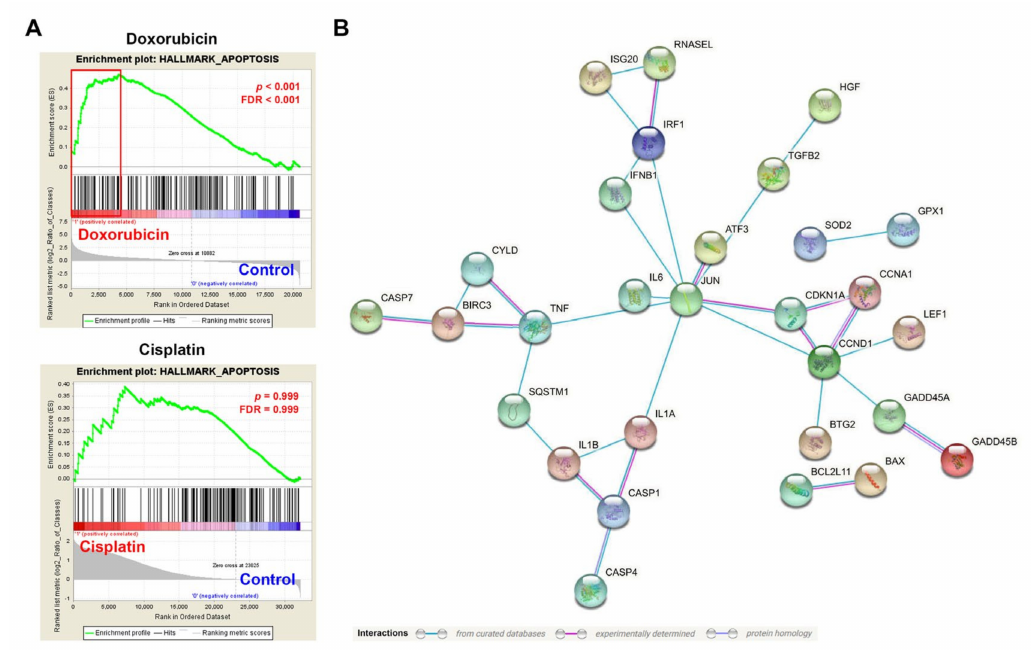
Figure 4. Gene set enrichment analysis (GSEA) for doxorubicin- and cisplatin-treated HeLa cells. ( A ) The enrichment plots for the apoptosis hallmark in doxorubicin- and cisplatin-treated HeLa cells. The leading edge genes are highlighted in the red squares. ( B ) The leading edge genes in doxorubicin-treated HeLa cells were analyzed using the STRING database for network construction.